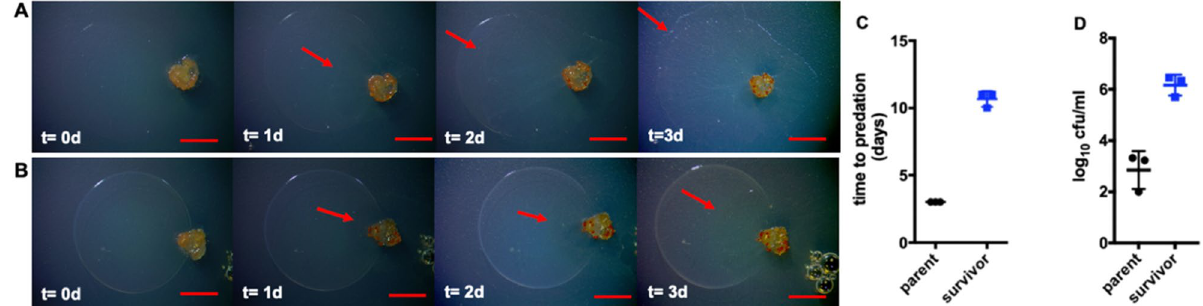
Figure 2. Predation assays depicting predator avoidance of survivor P. putida on nutrient-free media. ( A ) Predation assay depicting complete swarming of C. ferrugineus on spotted prey lawns with no visible parent P. putida biomass after 3 days (t = d3) red arrows indicate C. ferrugineus swarm edge. ( B ) Predation assay depicting predator avoidance observed from survivor P. putida lawns and visible biomass remaining with minimal C. ferrugineus swarming after 3 days (t = d3); red arrows indicate C. ferrugineus swarm edge. ( C ) Time to predation data for parent P. putida and survivor P. putida (n = 3; p ≤ 0.002) with ( D ) end point CFU data (n = 3; p ≤ 0.006) to determine differences in cell viabilities post-swarming. Unpaired t-test with Welch’s correction used for statistical analyses included in ( C , D ); all scale bars depict 1